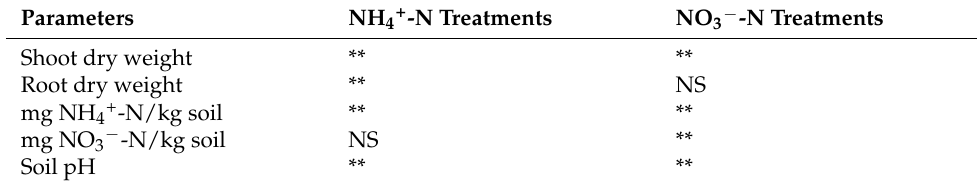
Table 3. Analysis of variance for growth and soil parameters (expt. 1, vegetative stage 1,5). Parameters